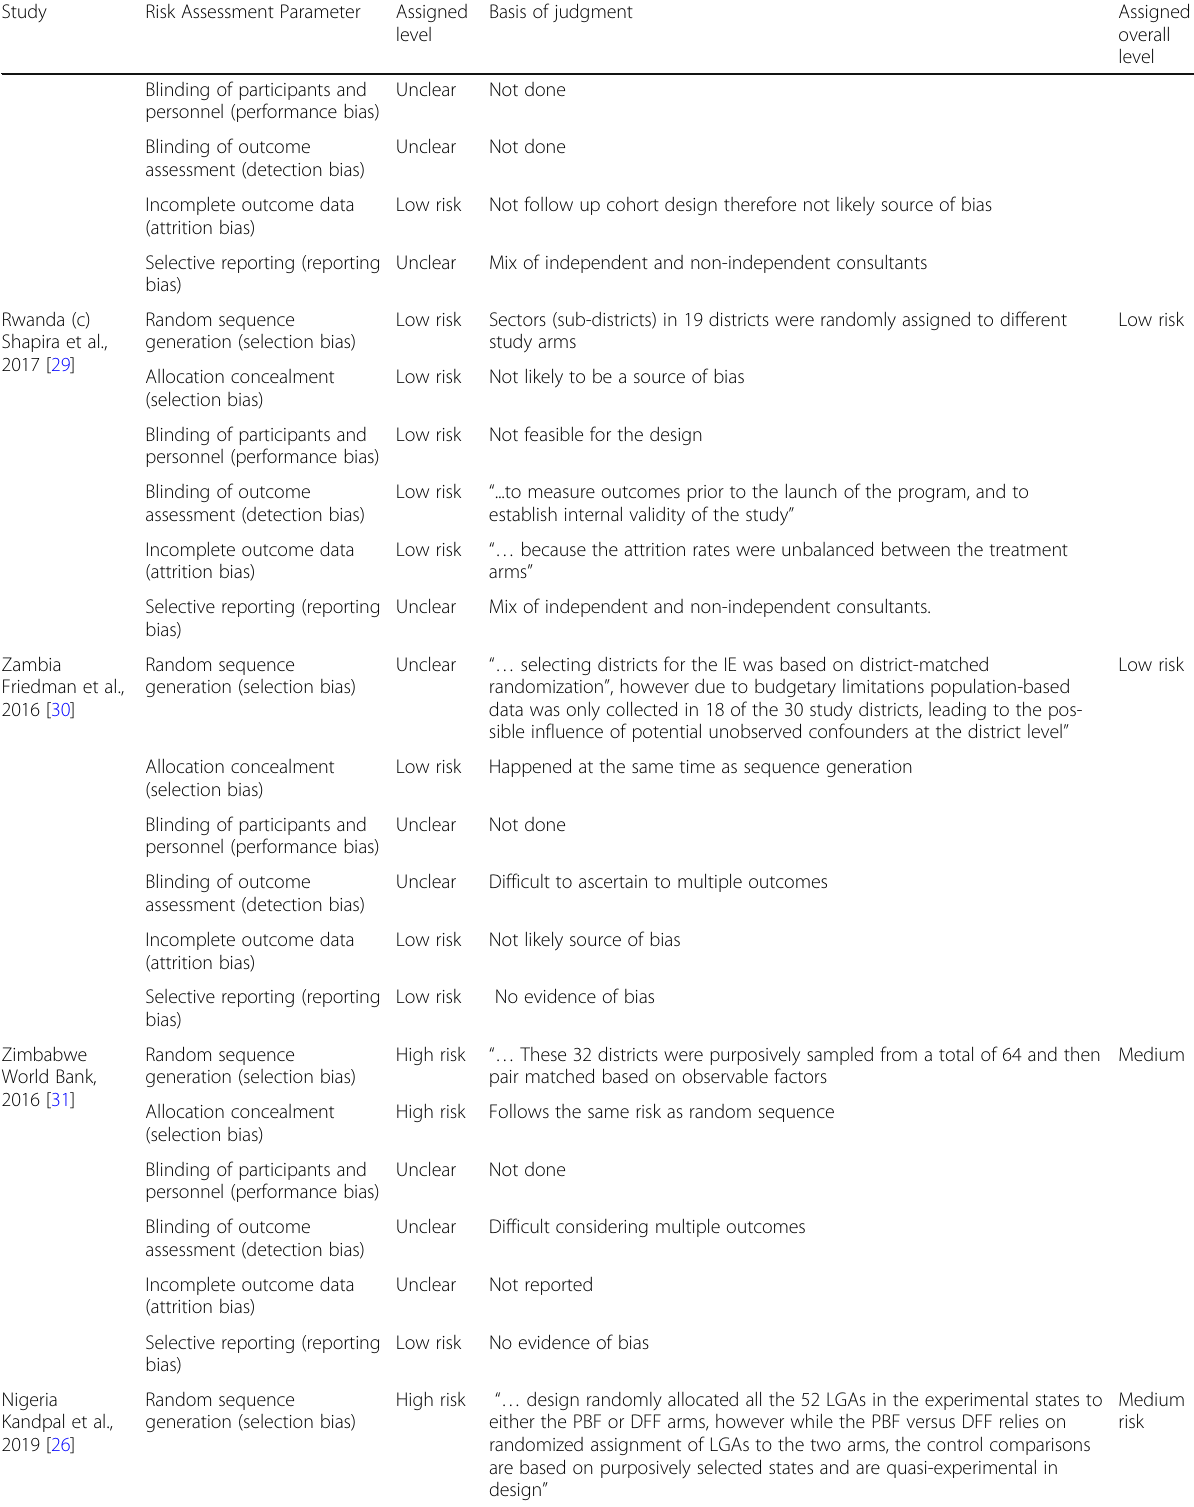
Table 3 Risk of bias assessment